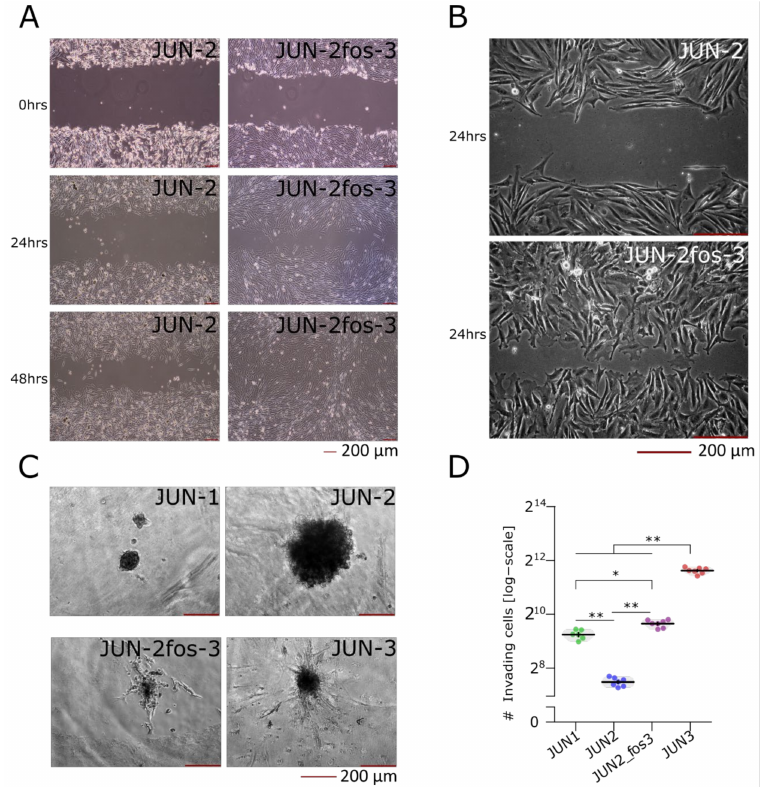
Figure 5. Invasion-related characteristics of JUN-sarcoma cell line. ( A – D ) JUN-2fos-3 cells are highly motile and invasive. ( A ) Cell motility after 24 and 48 h in vitro wound-healing test. The newly established JUN-2fos-3 cell line was highly motile in the in vitro wound-healing assay compared to its mother cell line JUN-2. Representative pictures were taken by the Olympus IX 70 inverted microscope at 40 × magnification (at 100 × magnification in detail ( B )). ( C ) Invasion of multicell tumour spheroids of JUN-sarcoma cell lines embedded into type I collagen at 100 × magnification. JUN-3 and JUN-2fos-3 cell lines showed comparatively intensive invasion, whereas the JUN-2 cell line was completely non-invasive. JUN-1 cell line displayed minimal invasiveness in type I collagen. ( D ) Matrigel in vitro invasion assay differed among JUN-sarcoma cell lines (permutational ANOVA: F 3,23 = 910, p < 0.001). Both the JUN-2fos-3 and the JUN-3 cell lines showed comparatively intensive invasion in this assay. * p < 0.05, ** p < 0.01 The statistical significances are based on permutational t -test with FDR correction. See Table S4 for effect sizes, their confidence intervals, and exact p -values. Each point represents an individual well. Violin plots with means ± SEM are